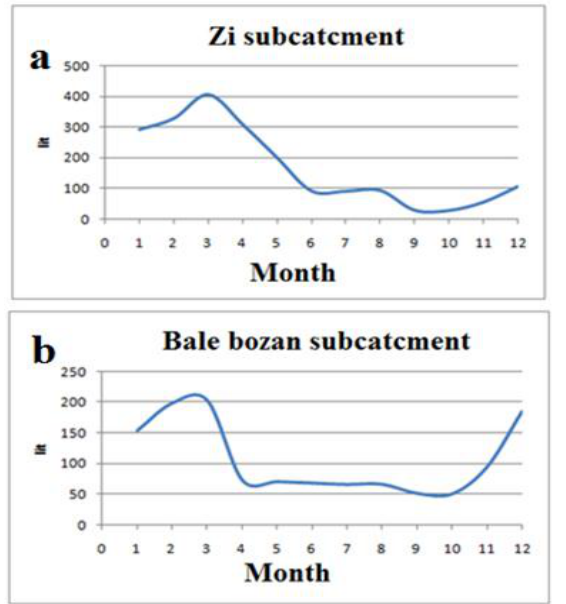
Fig 6. Monthly changes in spring discharge.